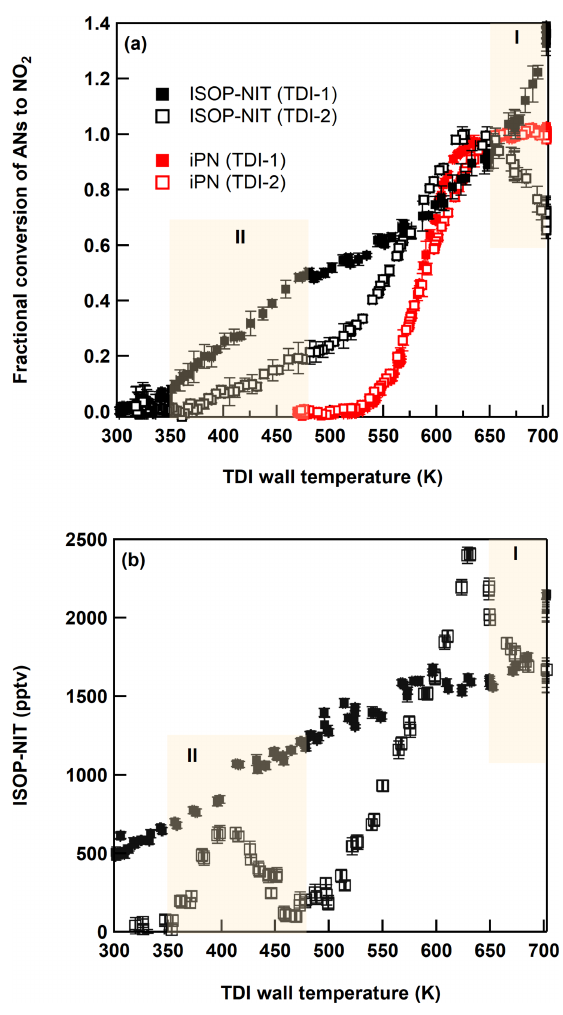
Figure 3. (a) Thermograms (relative to the signal at 650K) of isoprene-derived organic nitrates (ISOP-NIT) and isopropyl nitrate (iPN) obtained with TDI-1 (solid symbols) and TDI-2 (open sym- bols) under dry conditions. (b) Absolute thermograms of ISOP-NIT obtained with TDI-1 (solid symbols) and TDI-2 (open symbols) un- der humid conditions (RH = 34%, 22 ◦ C). Regions (I and II) with unexpected detection of NO 2 are shaded yellow. Error bars denote standard deviation (1 σ , 30s) of the signal.